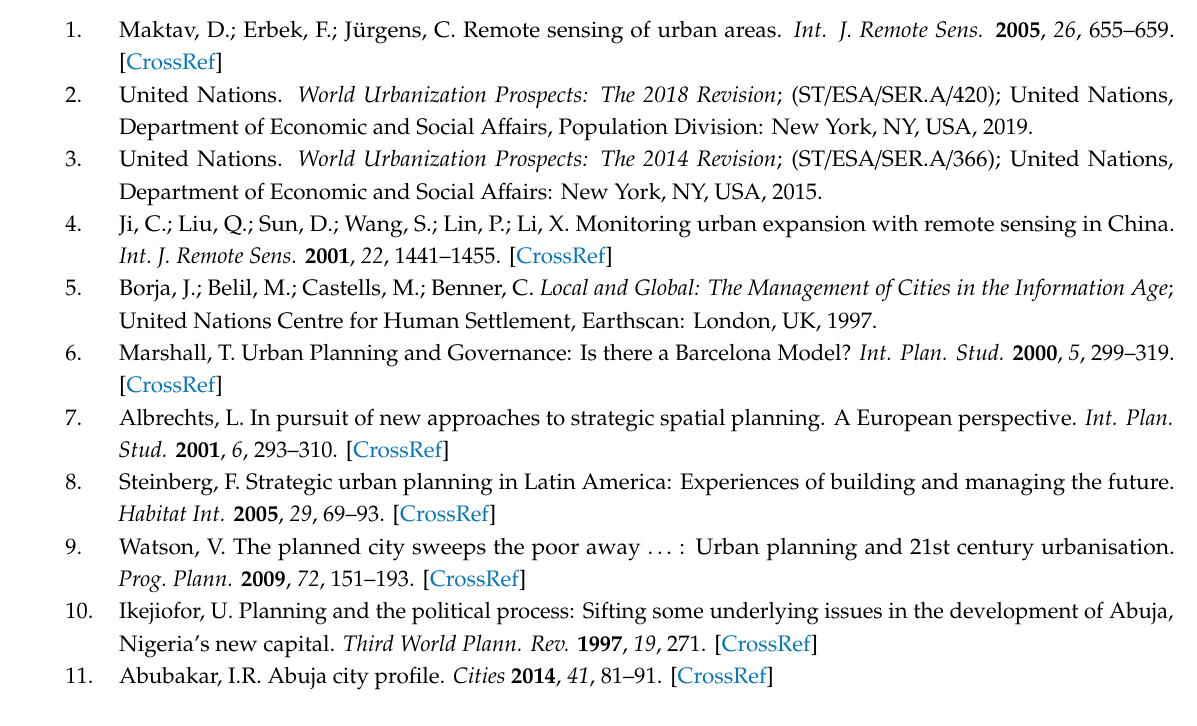
Table S1: Land cover class training and testing data for the 1975–2014 Landsat images of Abuja. Table S2: Error matrix for Abuja land cover classification using 1975 Landsat multispectral scanner image. Table S3: Error matrix for Abuja land cover classification using 1986 Landsat thematic mapper image. Table S4: Error matrix for Abuja land cover classification using 1990 Landsat thematic mapper image. Table S5: Error matrix for Abuja land cover classification using 1999 Landsat thematic mapper image. Table S6: Error matrix for Abuja land cover classification using 2002 Landsat-enhanced thematic mapper plus image. Table S7: Error matrix for Abuja land cover classification using 2009 Landsat-enhanced thematic mapper plus image. Table S8: Error matrix for Abuja land cover classification using 2014 Landsat operational land imager